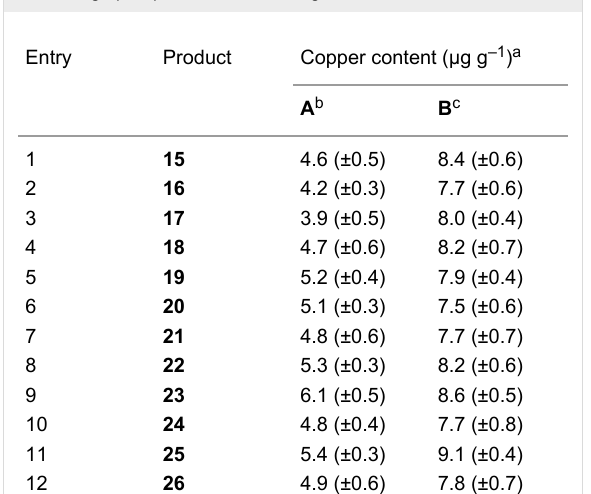
Table 2: Copper contents in the triazole products after column chromatographic purification on silica